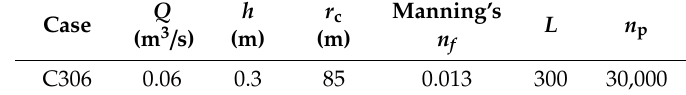
Table 1. Experimental and simulation conditions in the meandering channel.